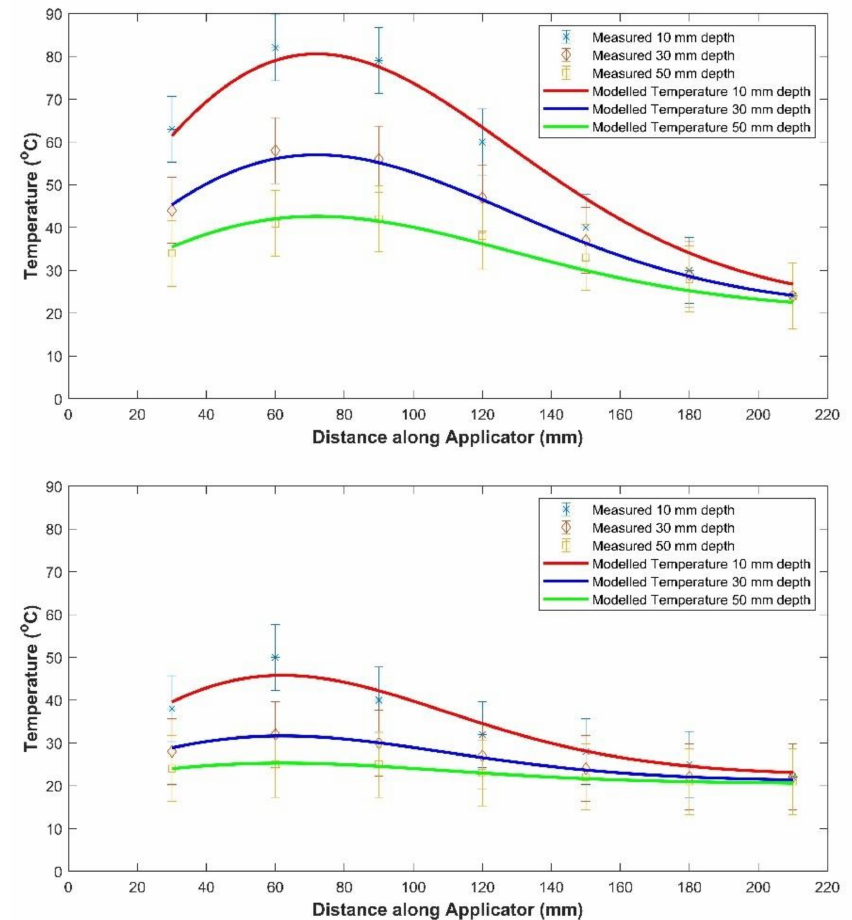
Figure 6. Temperature distribution in the soil along the comb slow-wave applicator’s central plane at F = 2.45 GHz, p = 3.5 kW, time of MW heating = 15 s, T o = 20 ◦ C, applied energy 53 kJ. Top graph–MC = 32%, density = 586 kg m − 3 , bottom graph–MC = 174%, density = 1070 kg m − 3 . (Error bars represent the standard error of the